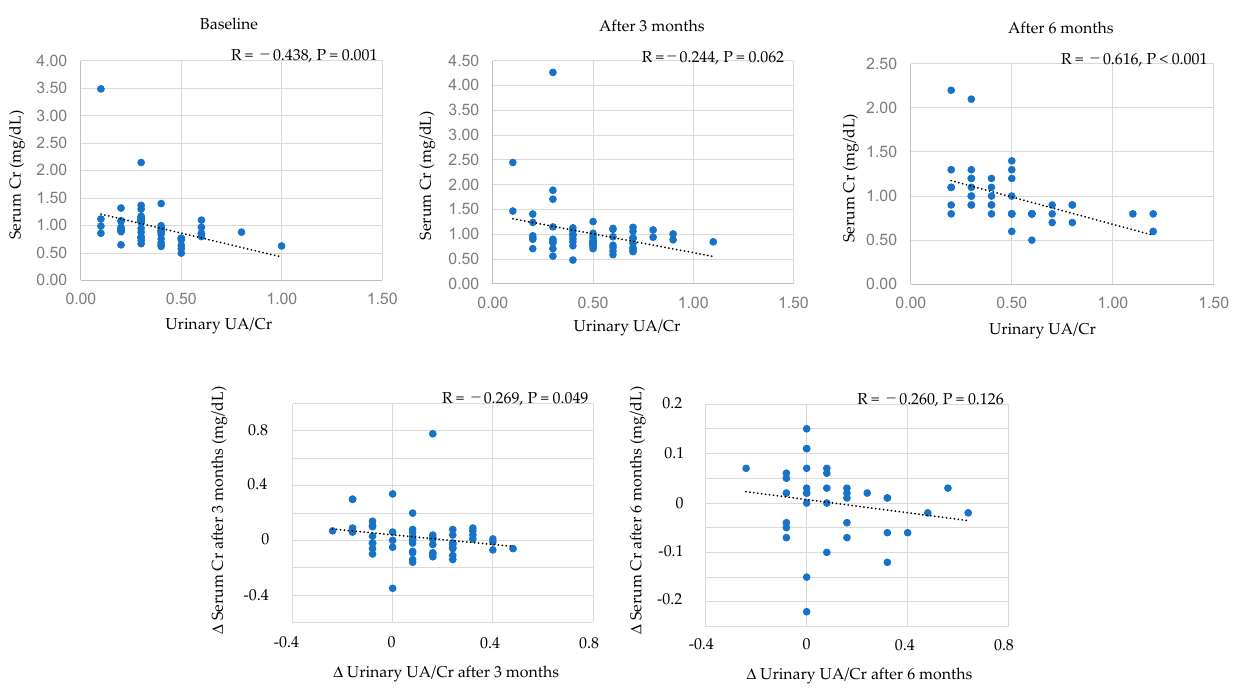
Figure 4. Correlations between urinary UA/creatinine and serum creatinine. Cr, creatinine. 3.7.2. Correlations between Urinary UA/Creatinine and eGFR Correlations between urinary UA/creatinine and eGFR were shown in Figure 5. Uri- nary UA/creatine was significantly and positively correlated with eGFR at baseline and at 6 months after the start of dotinurad, and urinary UA/creatine tended to be positively correlated with eGFR after 3 months. Change in urinary UA/creatine tended to be positively correlated with change in eGFR after 3 months.